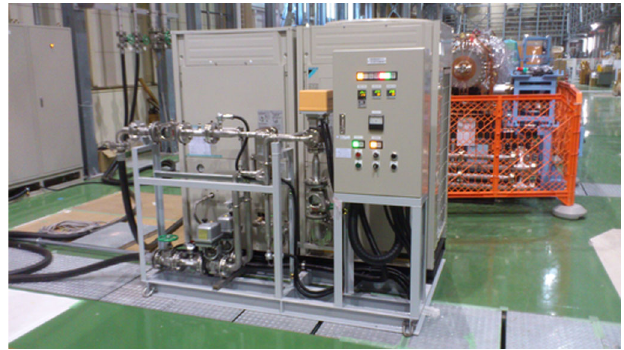
FIG. 4. Photograph of the water-temperature-control